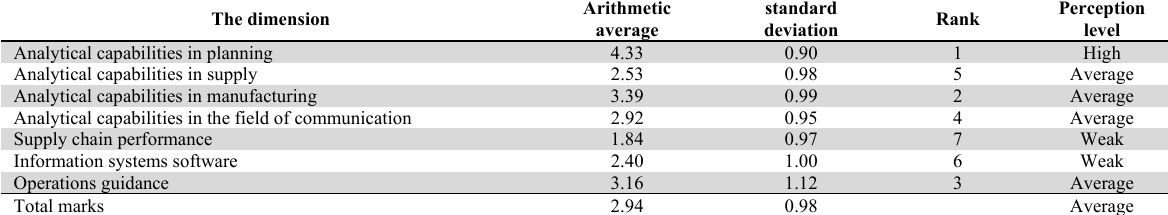
formance in the supply chain